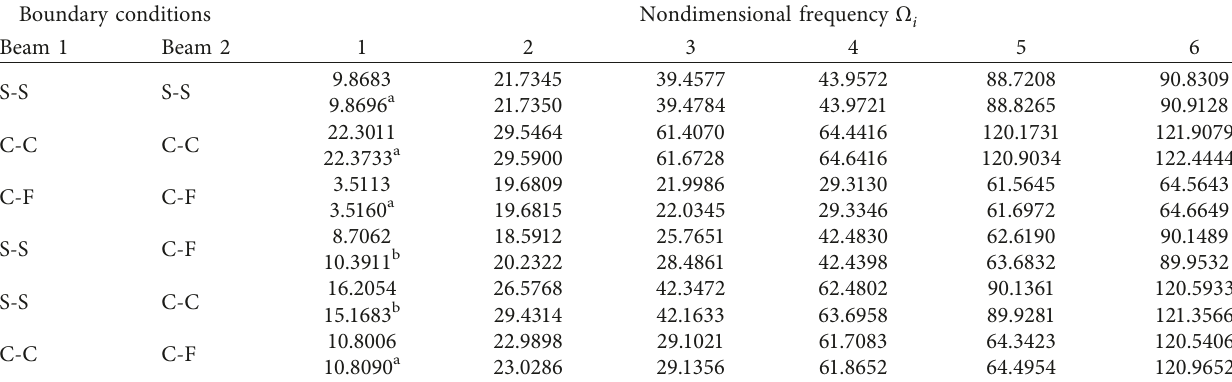
Table 1: The first six nondimensional frequency Ω for the uniform double-beams with different boundary conditions ( k K � c